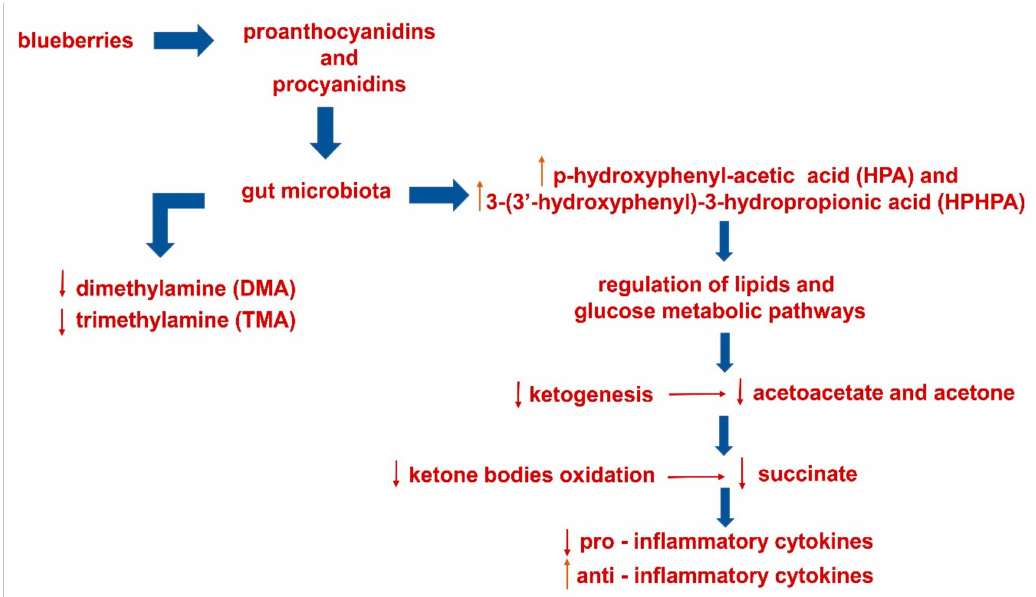
Table S1: A total of 75 chemical shift bins and relative range (ppm) in which 1 H-NMR spectrum has been